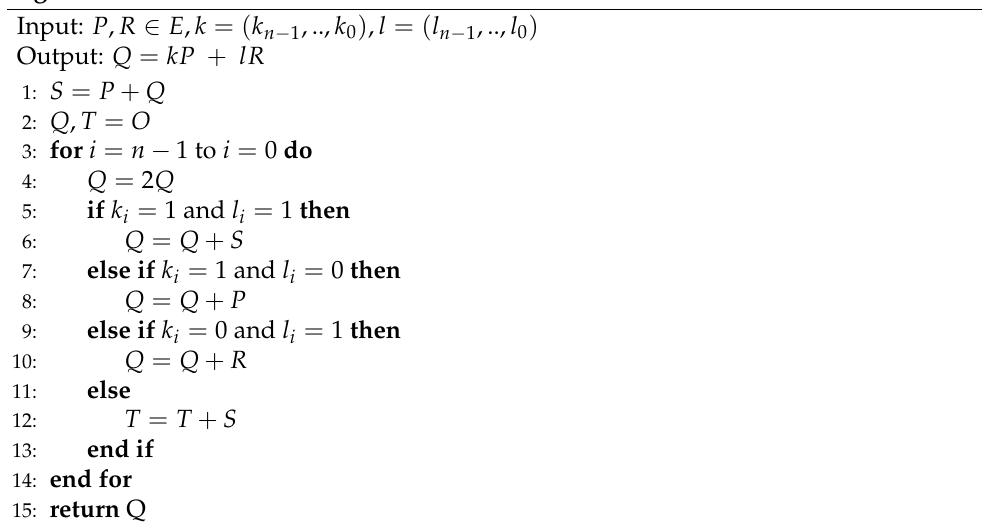
Algorithm 4 Constant Time Version of Shamir’s